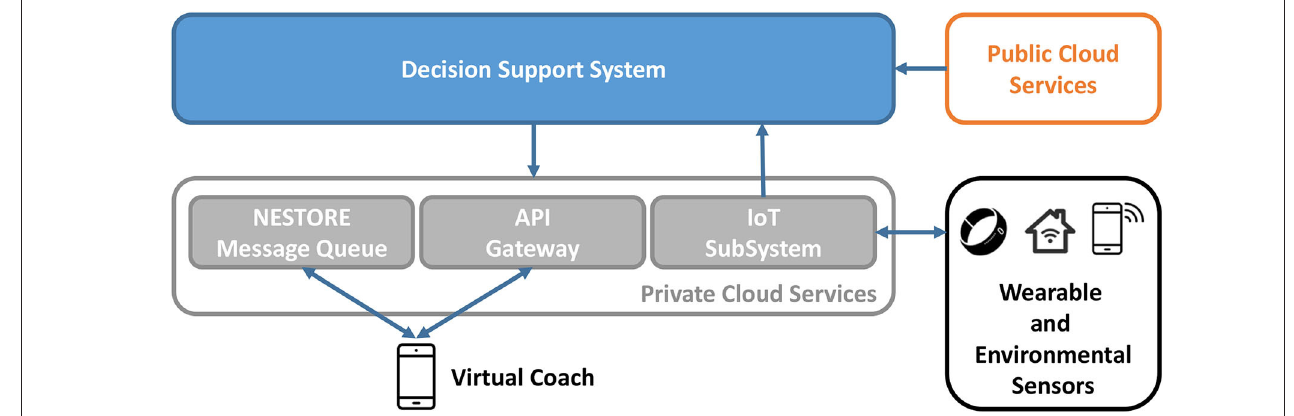
FIGURE 8 | Overview of The DSS